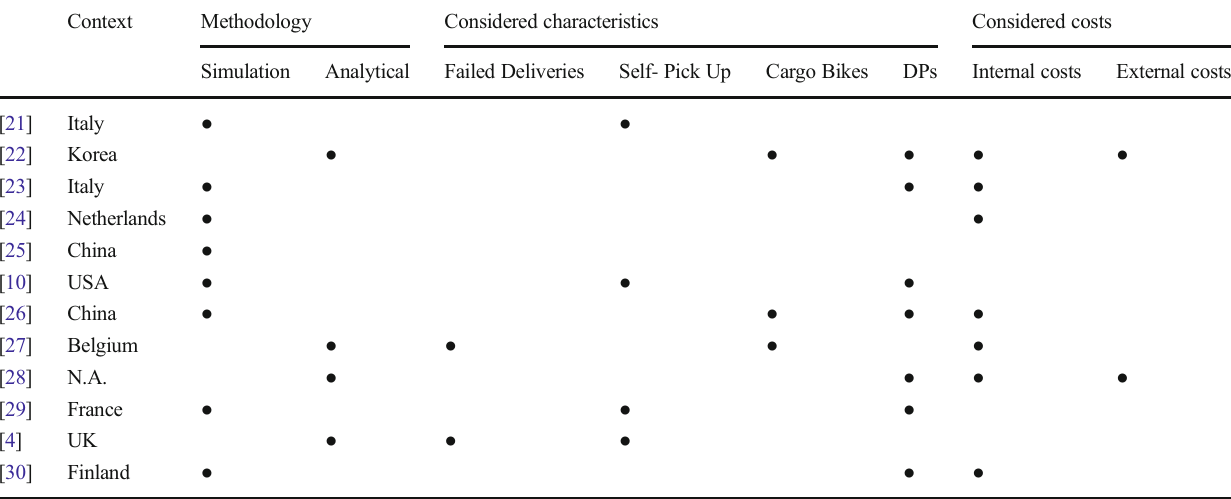
Overview about studies in urban logistics and last-mile distribution on e-commerce